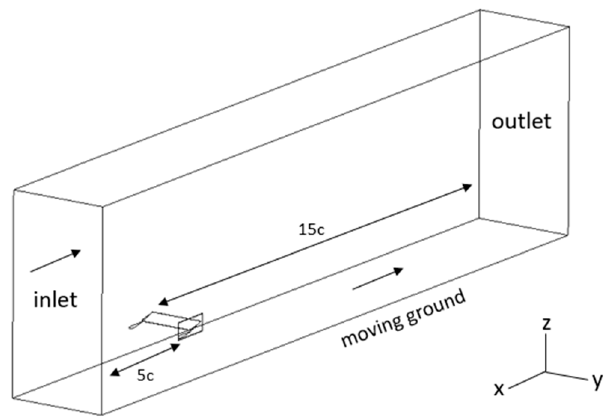
Figure 3. Three-dimensional schematic computational domain.